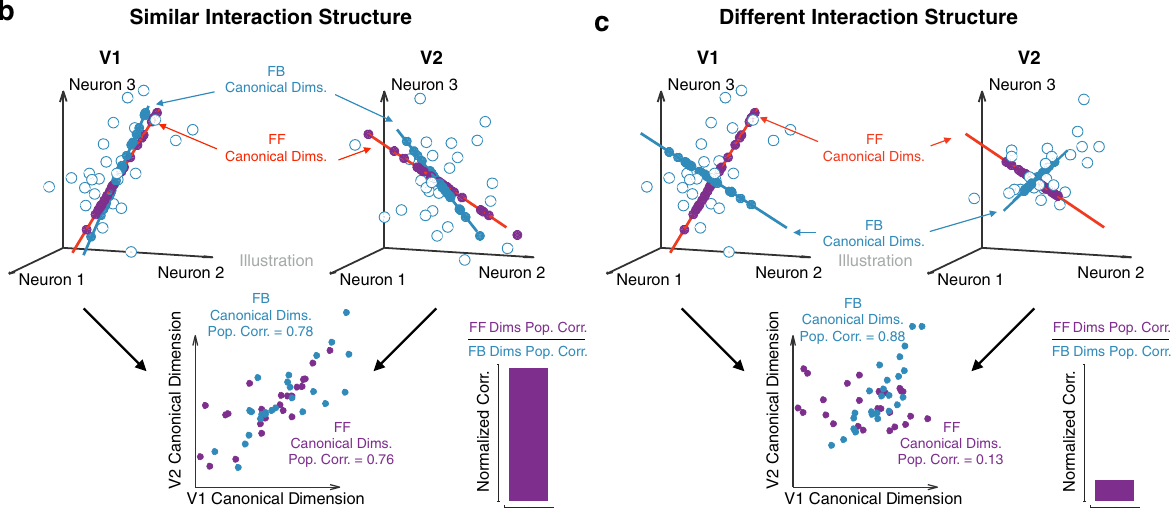
Fig. 5 Illustration of how to assess whether feedforward- and feedback-dominated interactions involve the same population activity patterns. a Canonical dimensions identi fi ed during a feedforward-dominated period in the trial (red dimensions). These are putative “ Feedforward ” (FF) canonical dimensions. Open red circles denote activity during the feedforward-dominated period. Solid red circles denote the projection onto the FF canonical dimensions. b We can then ask whether these FF canonical dimensions generalize to a feedback-dominated period. One possibility is that the interaction structure (de fi ned using the canonical dimensions) remains stable across the two periods. In this case, the FF canonical dimensions (red dimensions) capture a similar level of correlation during the feedback-dominated period as the canonical dimensions identi fi ed during this period, the putative “ Feedback ” (FB) canonical dimensions (blue dimensions). As a result, the normalized correlation, the ratio of the population correlation for the FF canonical dimensions to that for the FB canonical dimensions (both computed in a cross-validated manner; see Methods), is close to 1. Open blue circles denote activity during the feedback-dominated period. Solid purple circles denote the projection of activity during the feedback-dominated period onto the FF canonical dimensions. Solid blue circles denote the projection onto the FB canonical dimensions. c Alternatively, the interaction structure might change across the two periods. In this case, the FF dimensions capture only a small fraction of the population correlation during the feedback-dominated period. Same conventions as in b